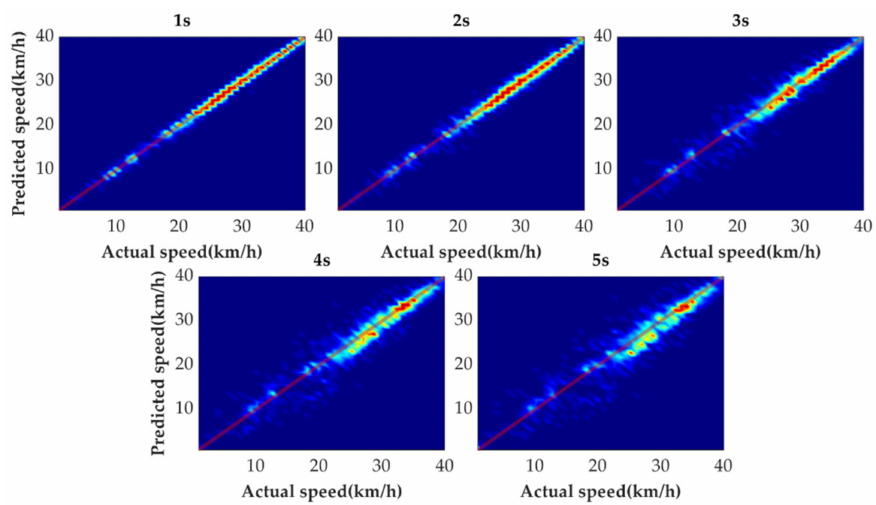
Figure 14. Heat map display of the predicted results of VSNet.